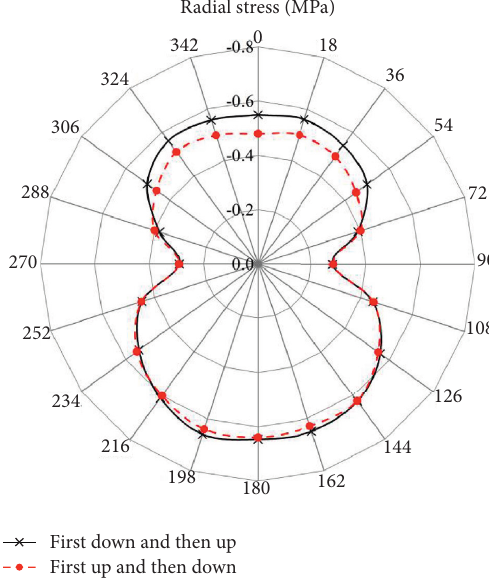
Figure 10: Radial stress of the lower tunnel